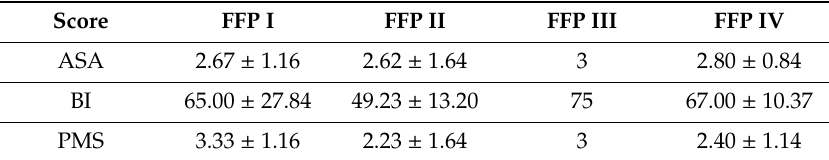
Table 5. Subgroup Characteristics.